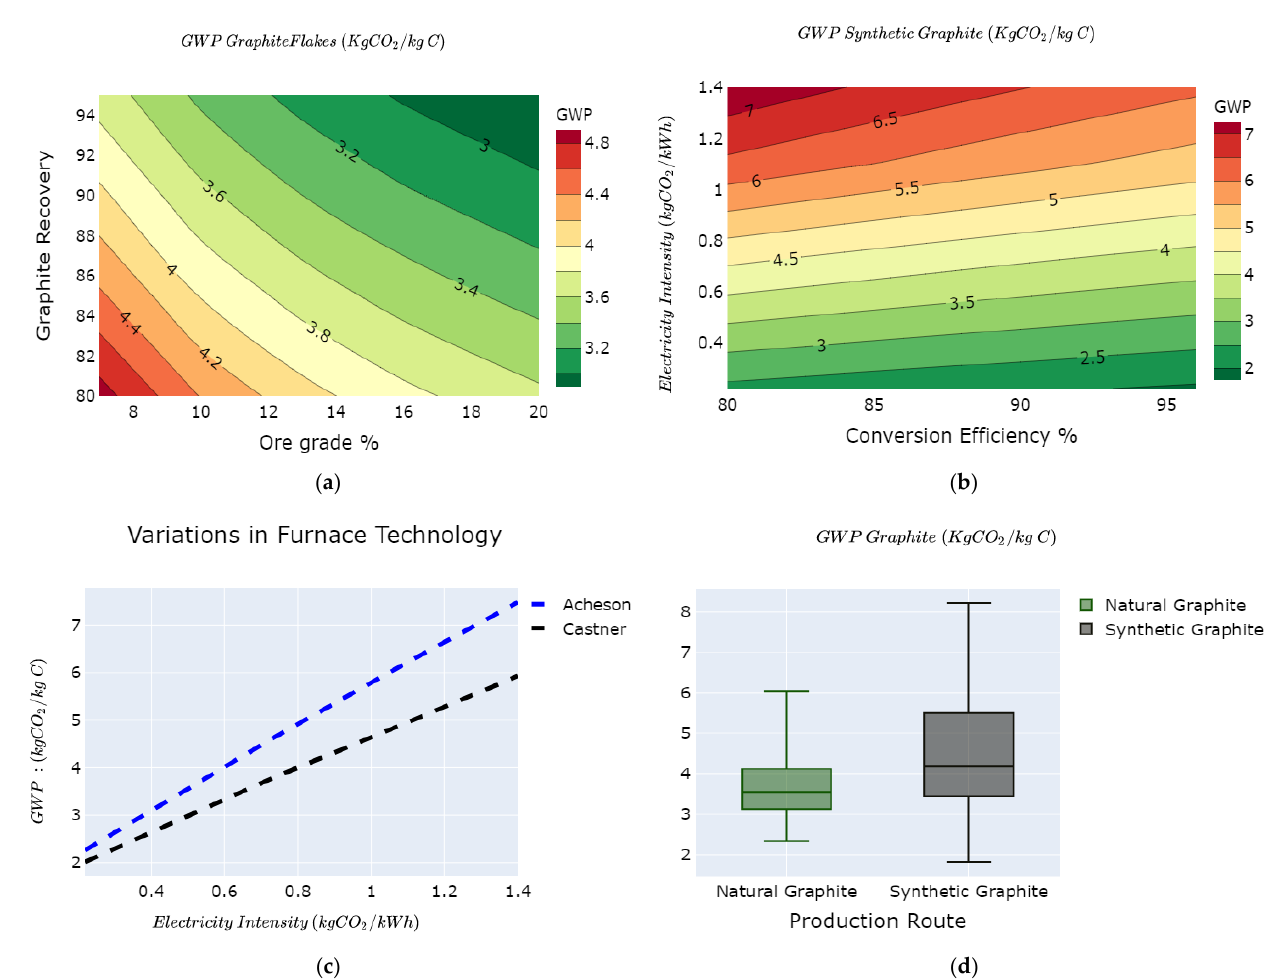
Figure 6. GWP variability of graphite as a function of: ( a ) natural graphite ore grade vs. recovery; ( b ) conversion efficiency vs. electricity mix intensity of synthetic graphite; ( c ) graphitization furnace and electricity mix intensity; and ( d ) overall GWP variations graphite value chain.